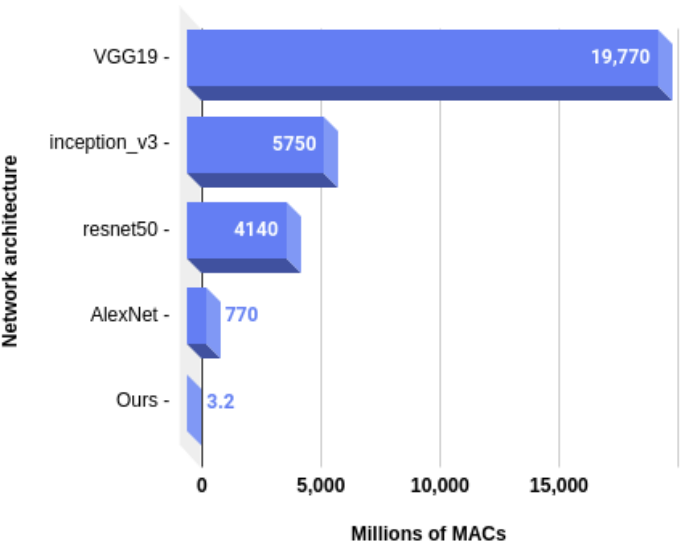
Figure 10. Number of computations needed by our model compared to popular CNN architectures.